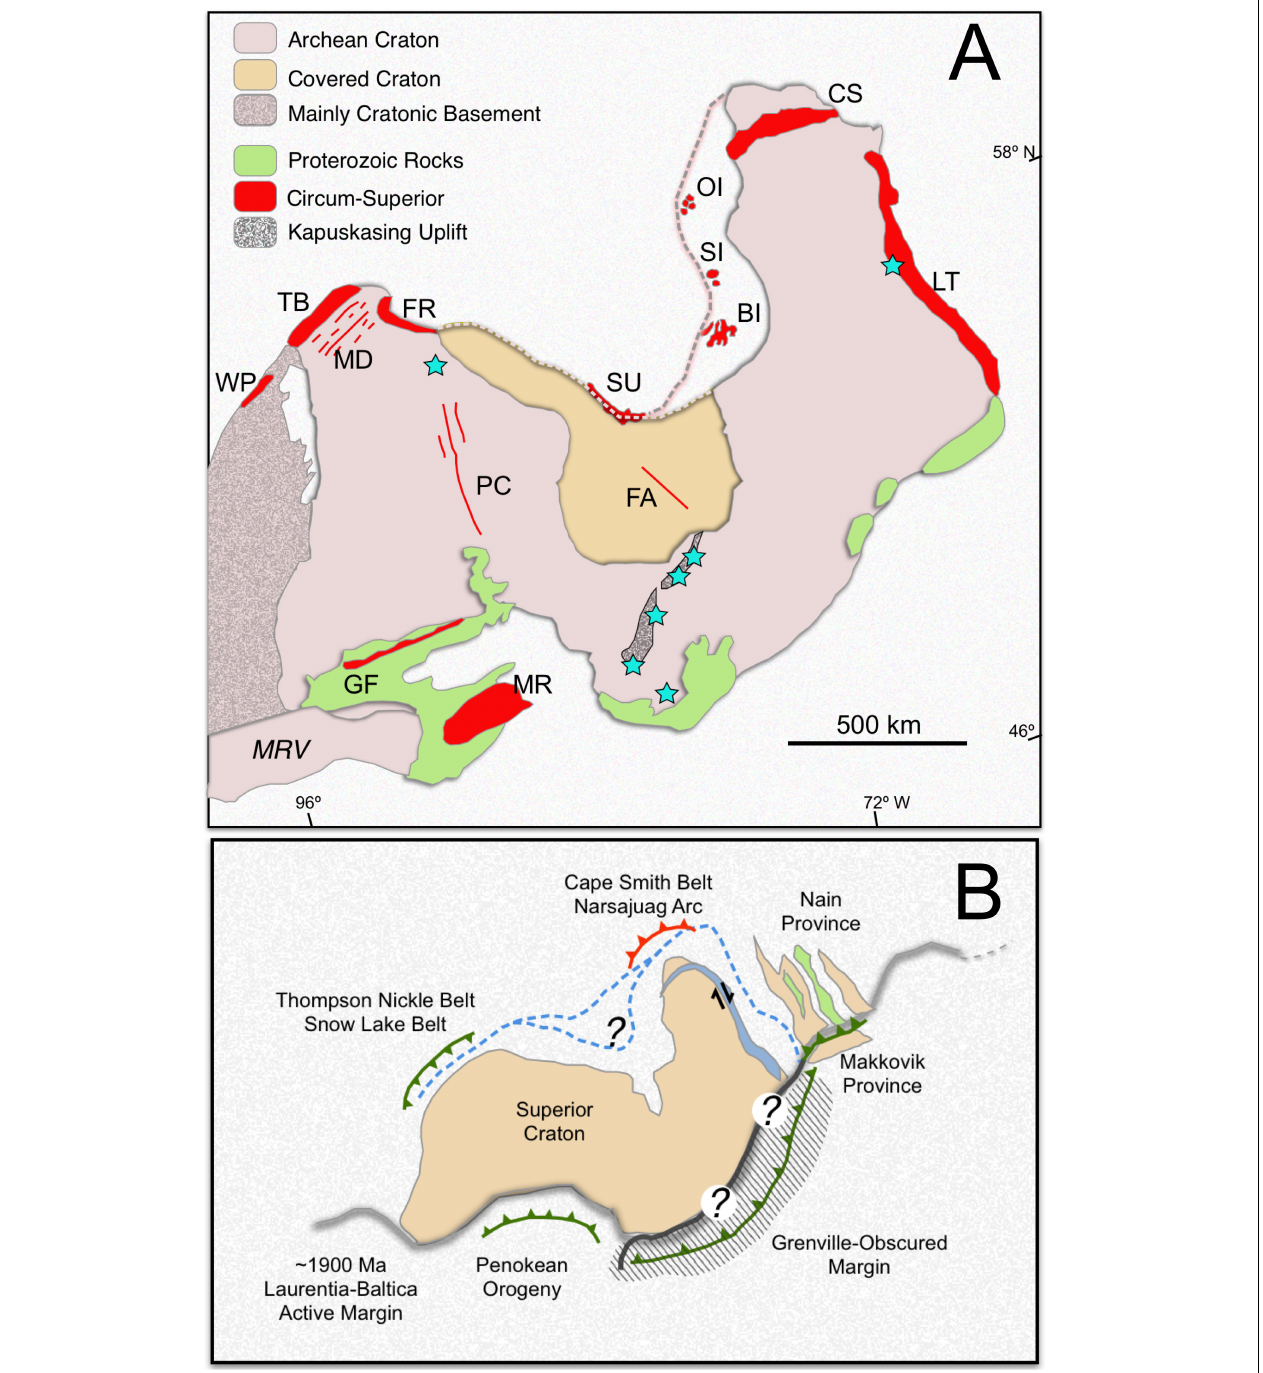
FIGURE 4 | (A) Map of the Superior Craton and ∼ 1885–1864 Ma Circum-Superior Belt. Red lines: ∼ coeval dikes; blue stars: ∼ 1885–1864 carbonitites. Dashed gray line: possible deep crustal extension of cratonic margin (see: Corrigan et al., 2009). MRV, Minnesota River Valley Terrane. Map adapted from Ciborowski et al. (2017) with modifications from Percival et al. (2012) and Waterton et al. (2017). ∼ 1885–1864 Ma mafic magmatism: BI, Belcher Islands; CS, Cape Smith Belt; FA, Fort Albany dykes; FR, Fox River Belt; GF, Gunflint Formation; LT, Labrador Trough; MR, Marquette Range Supergroup; MD, Molson dykes; OI, Ottawa Islands; PC, Pickle Crow dyke; SI, Sleeper Islands; SU, Sutton Inlier; TB, Thompson Nickel Belt; WP, Winnipegosis Belt. (B) Convergent margin processes around the Superior Province Craton at ∼ 1900 Ma. Blue dashed lines indicate possible locations of the Superior Craton margins at ∼ 1.9 Ga (Corrigan et al., 2009). Given the co-temporal flips to craton-facing subduction in the Penokean Orogeny and the Makkovik Province, a similar flip may have occurred all along the southern Superior Craton. Simplified from Ketchum et al. (2002), with additions from sources for map in panel (A) , and St-Onge et al. (2006) and Schulz and Cannon (2007).